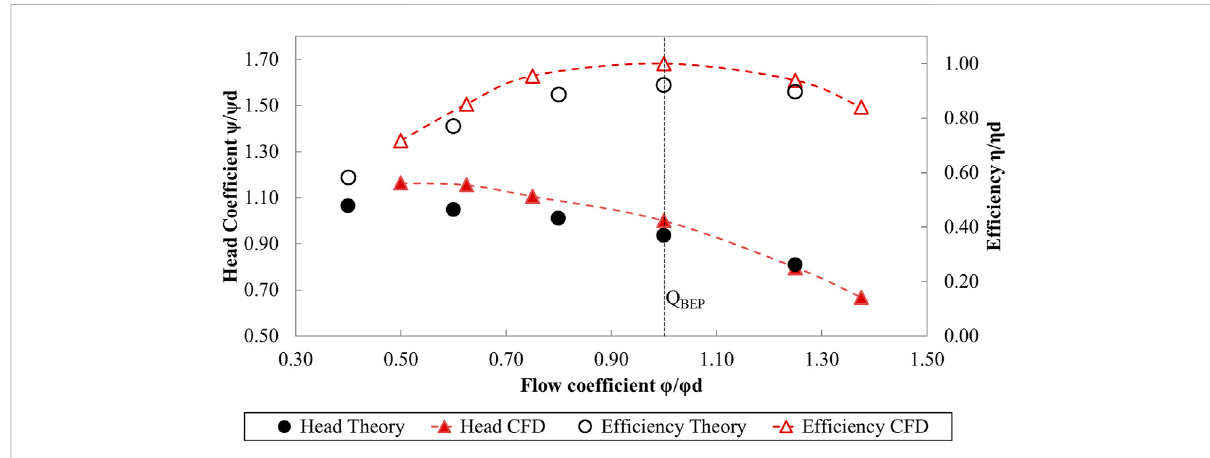
FIGURE 4 Comparison of theoretical calculations and numerical simulations.